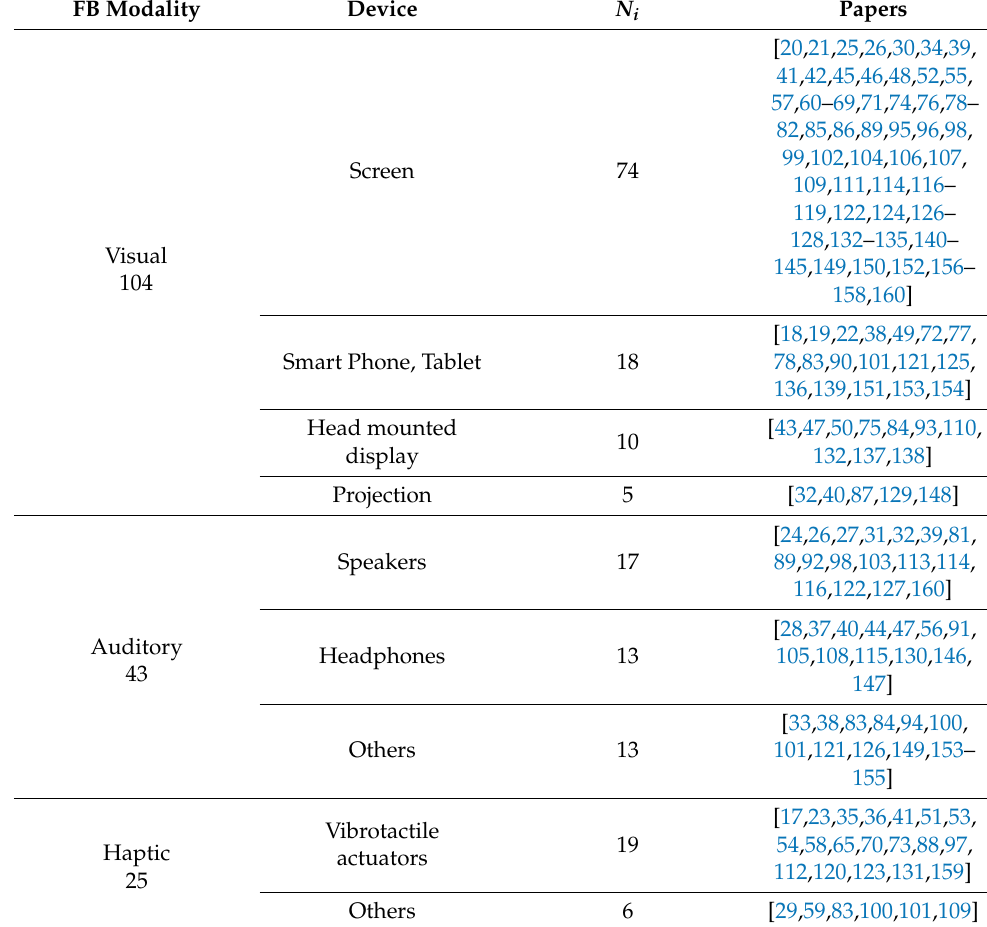
Table 7. Papers classified according to the feedback modality and device type